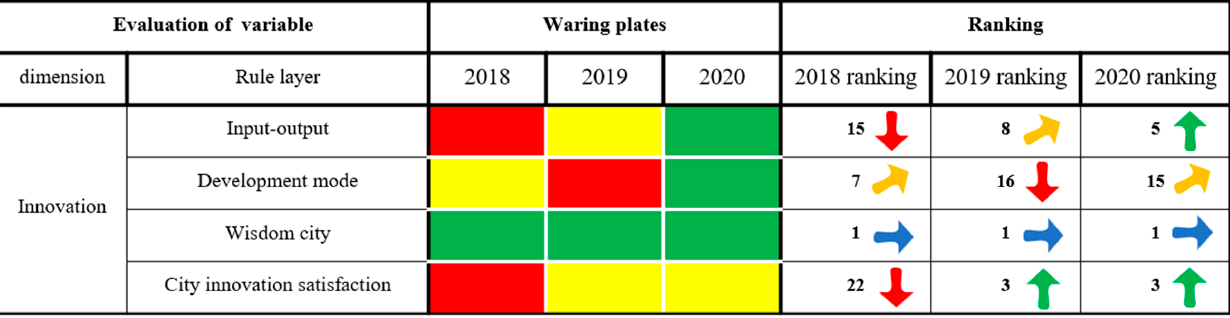
Figure 7. The results of the innovation dimension of city health examination and evaluation in Xining City.